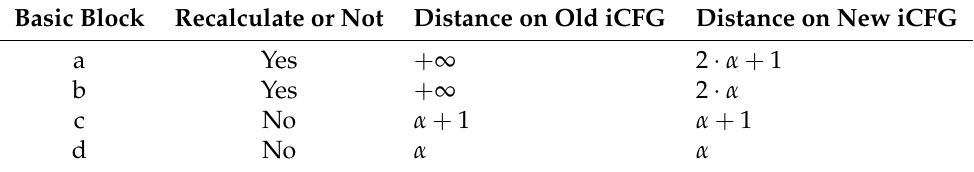
Table 2. Example of updating